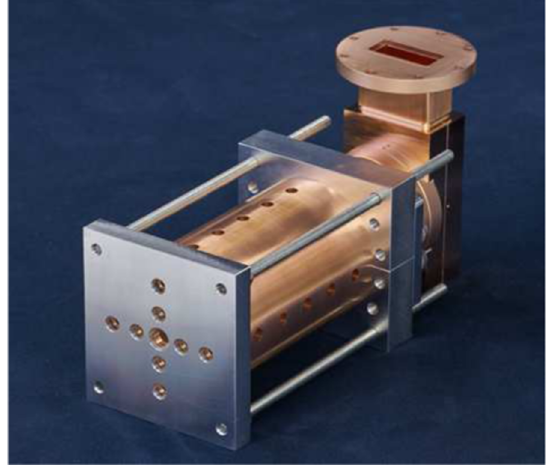
FIG. 11. Photograph of the fabricated DAA structure assembly including the input coupler and the TE-TM mode